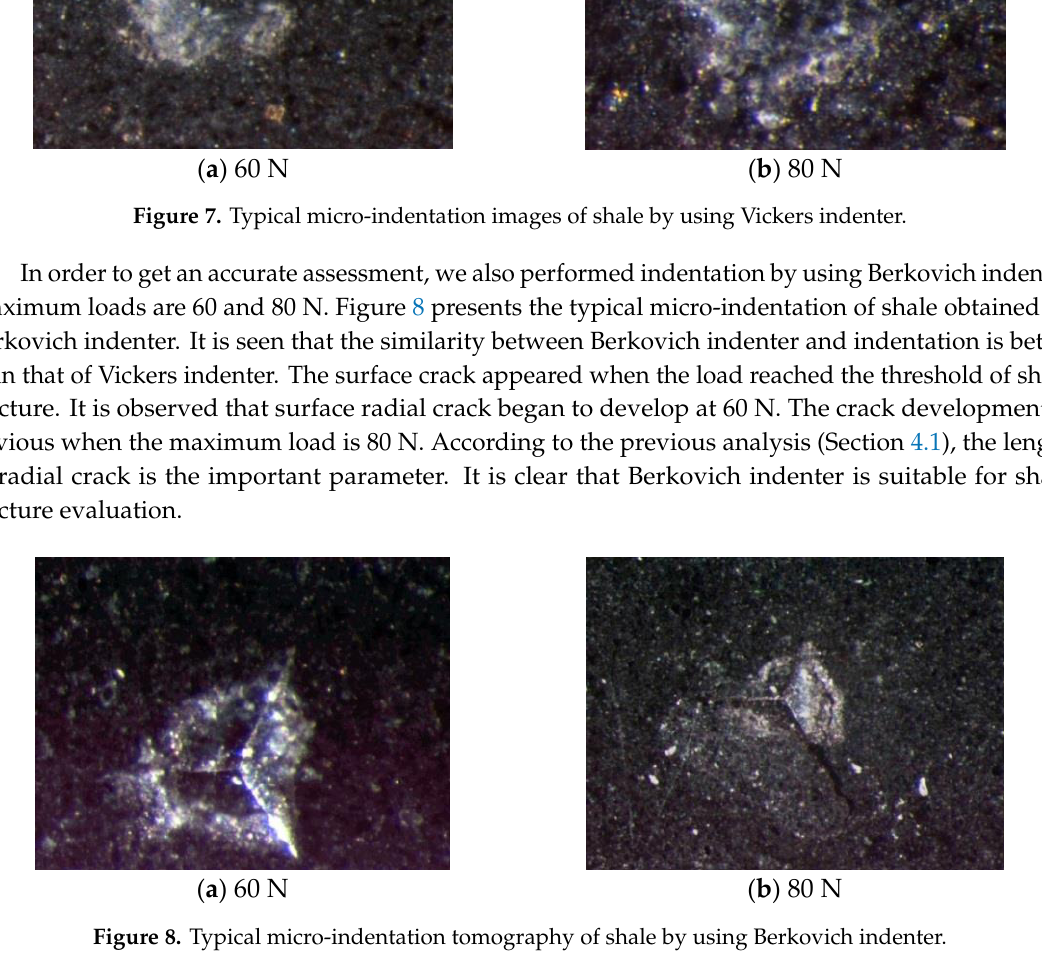
Figure 8. Typical micro-indentation tomography of shale by using Berkovich indenter.